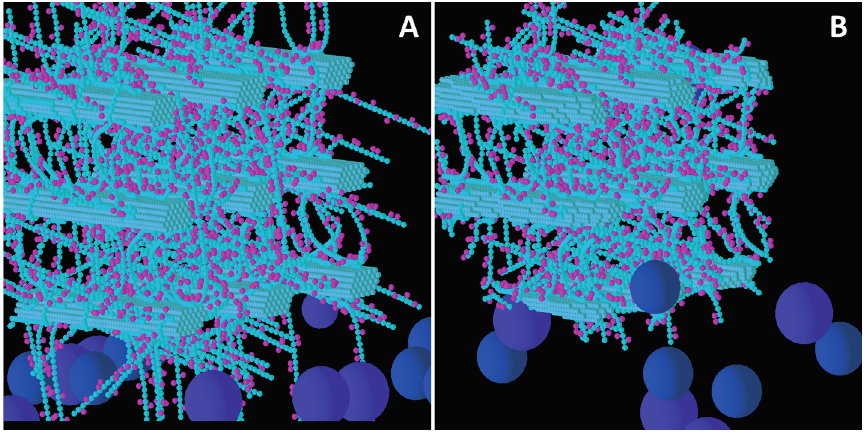
Figure 4. Initial structure of the High XG model cell wall ( A ) and the end result of its degradation after a simulation run ( B ). Glucose and xylose are represented by the smaller spheres coloured blue and magenta, respectively. Larger spheres coloured purple and blue represent Cel51A, and Cel9D, respectively. Enzymes shown in pane A are in their original positions, located in the hypothetical biofilm